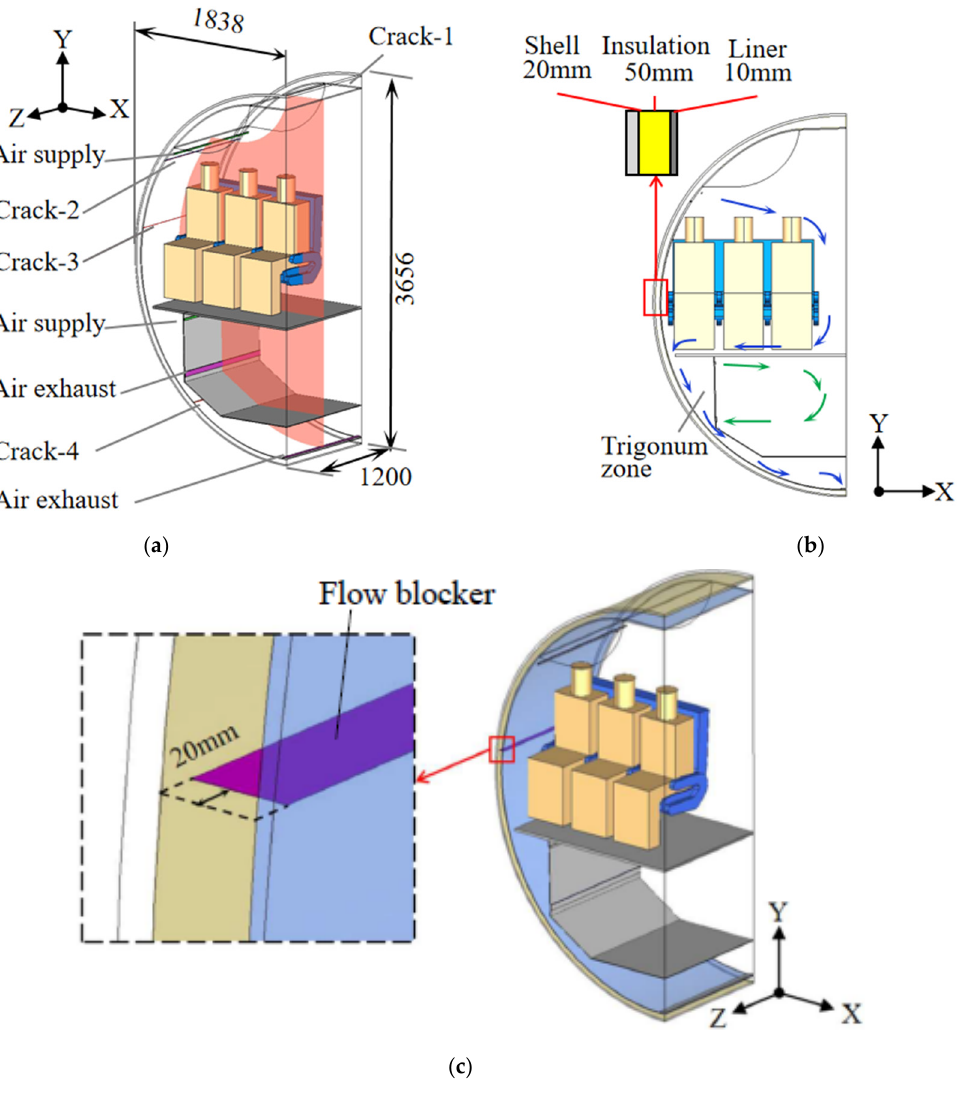
Figure 2. Schematic diagram of half an aircraft cabin model for investigation: ( a ) 3D diagram, ( b ) 2D diagram and ventilation flow paths; ( c ) schematic diagram of flow blocker in Case 16.